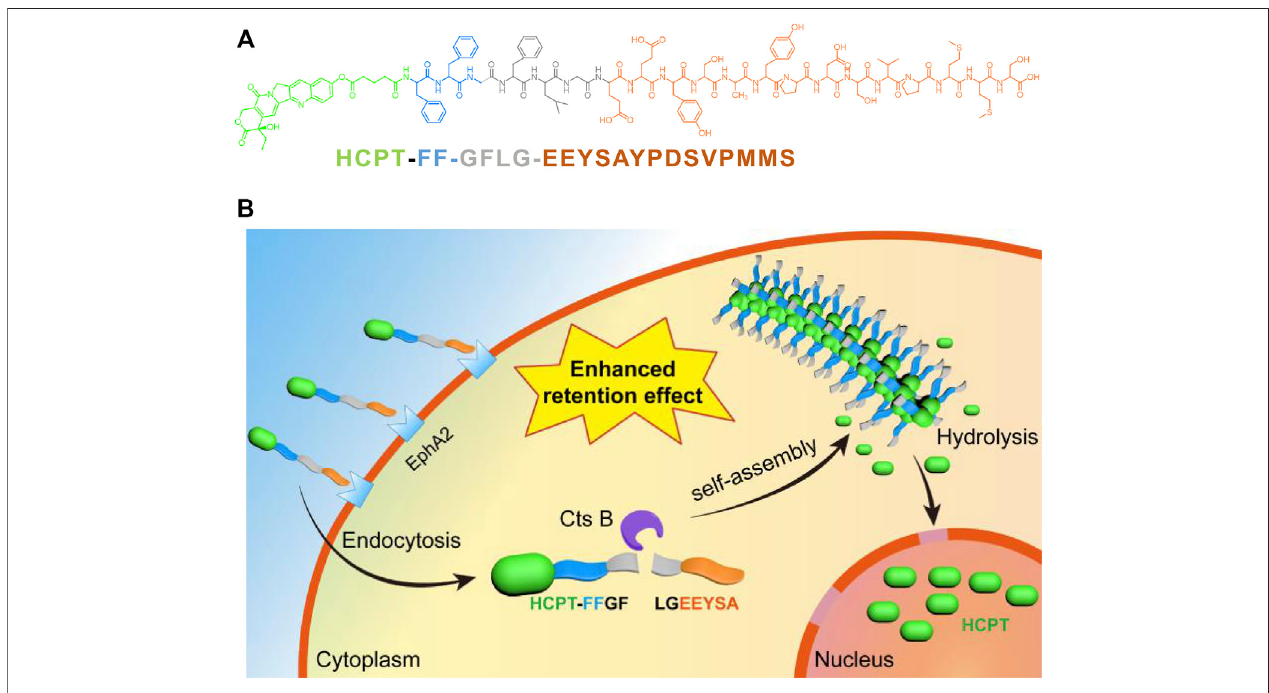
FIGURE2|(A) The molecular structure ofHCPT-FF-GFLG-EEYSAYPDSVPMMS; (B) The illustration ofthebladdertumor cell targeting,intracellular fi brillationand drug release of HCPT-FF-GFLG-EEYSAYPDSVPMMS(Zeng et al., 2021a).